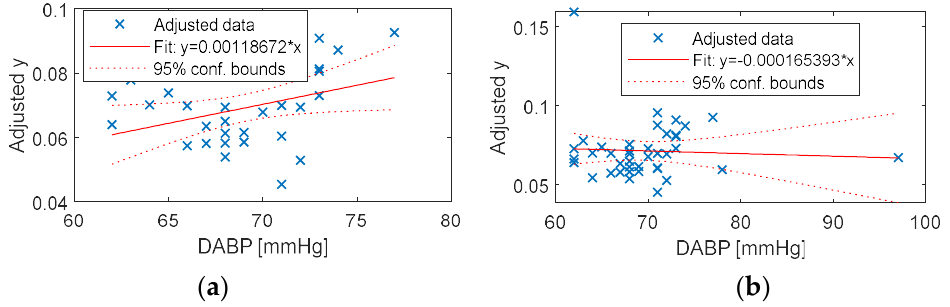
Figure 6. Example of outlier PPG signal with BP values effect to the linear relationship characteristic: ( a ) outlier record is not integrated; ( b ) outlier record integrated to the database.